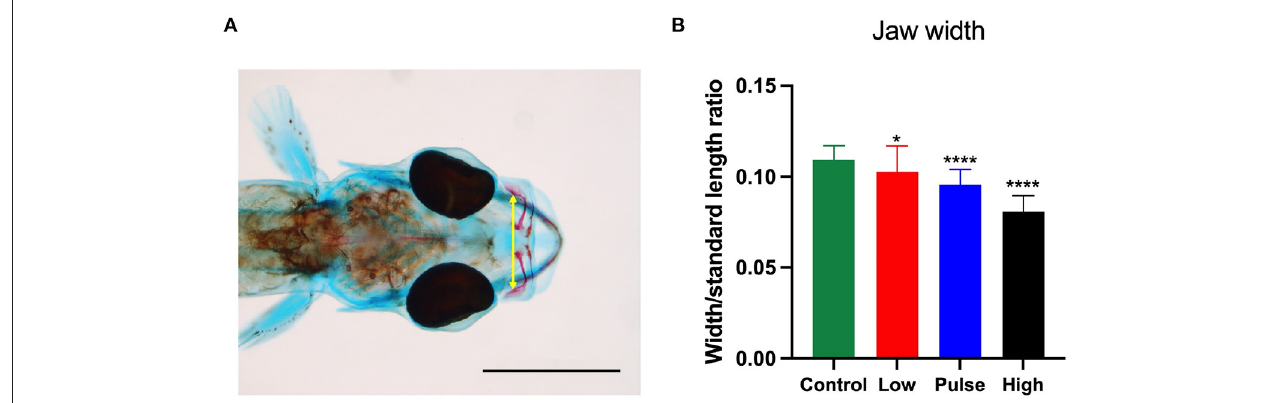
FIGURE 5 | Jaw width to standard length ratio at 19 dph in the haddock larvae. (A) shows how the width was measured, while (B) shows the impact of oil exposure in the treatment groups. Control and low: n = 35; pulse: n = 37; high: n = 28. p < 0.05 = *, p < 0.0001 = ****. Scale bar: 1mm.